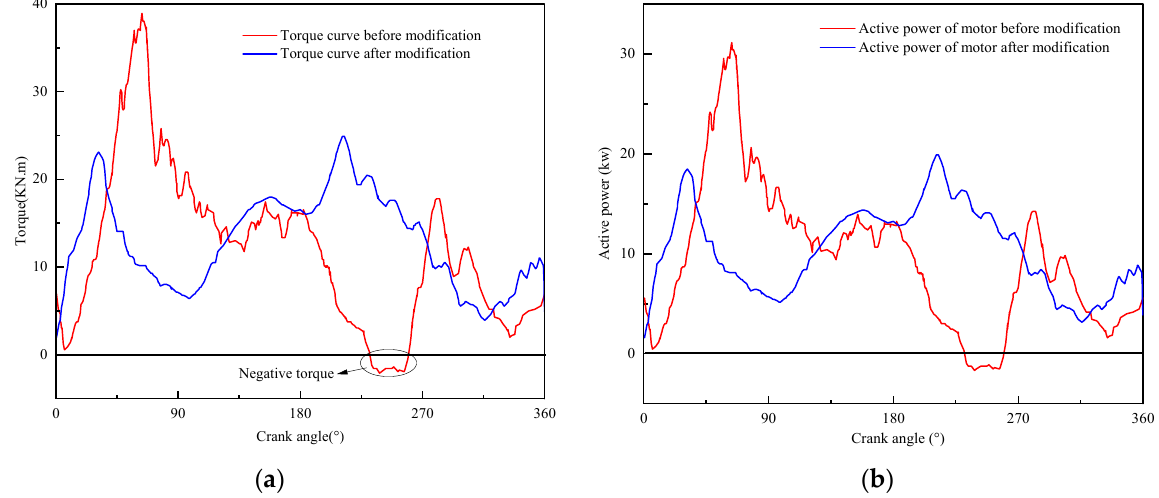
Figure 15. Force diagram of the linkage-speed increase gearbox. ( a ) Complete analysis diagram of linkage-speed increase gearbox; ( b ) Partial enlarged analysis diagram of linkage-speed increase gearbox. Table 1. Comparison of working conditions of B2-D2-56 pumping well before and after transfor- mation.